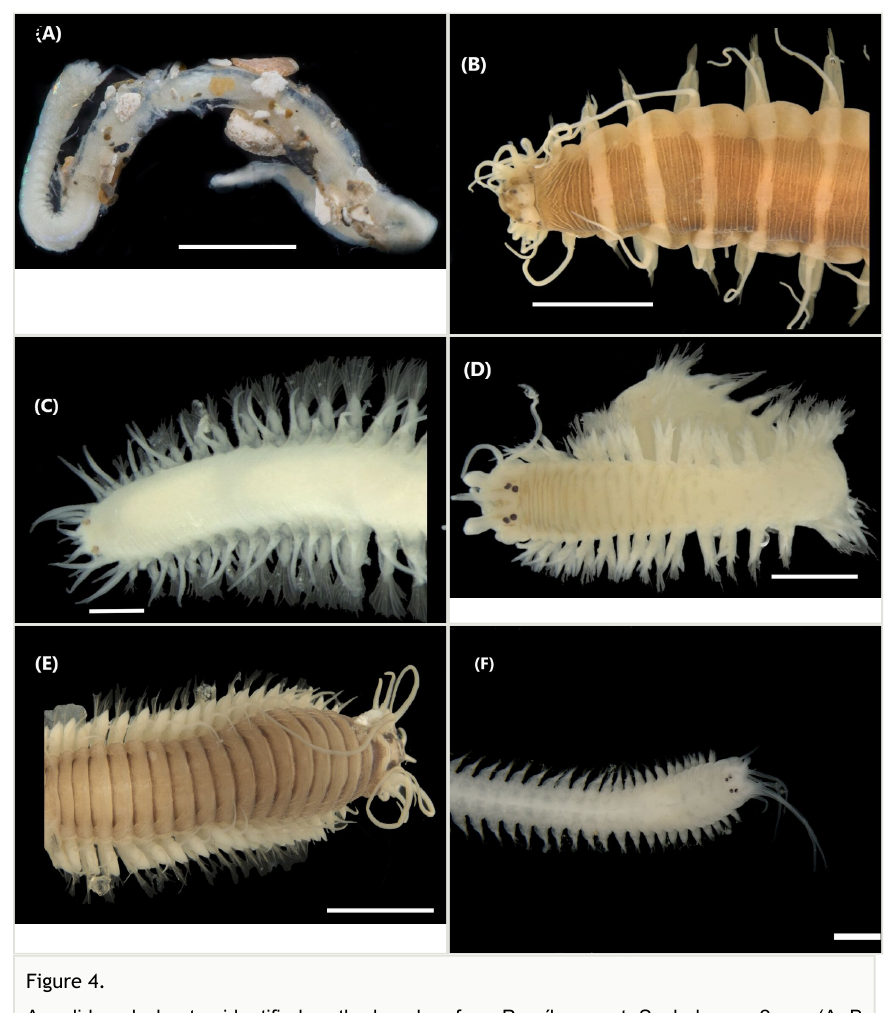
Figure 4. Annelids polychaetes identified on the beaches from Paraíba coast. Scale bars = 2 mm (A ,B and E), 500 µm (C), 1 mm (D and F). Photos: (A) by Freitas, P.; (B-F) by Prata,